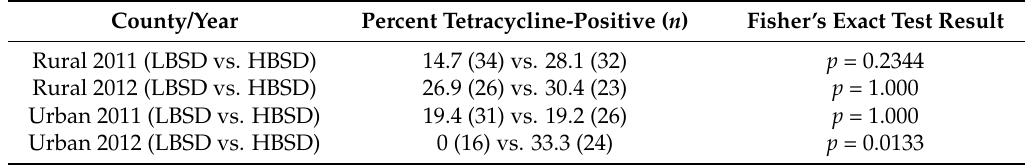
Table 3. Comparison of raccoon tetracycline deposition (at 75 baits/km 2 ) with deployment of LBSD versus HBSD in rural and urban environments in Florida,